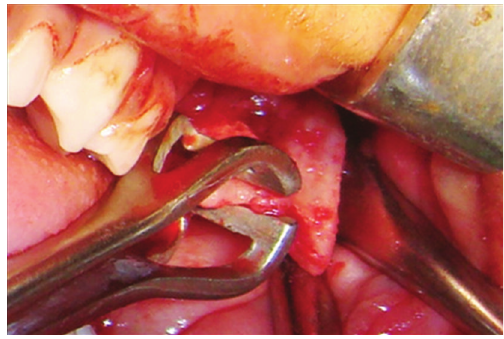
Figure 6: Intraoperative photograph showing excision of the lesion.